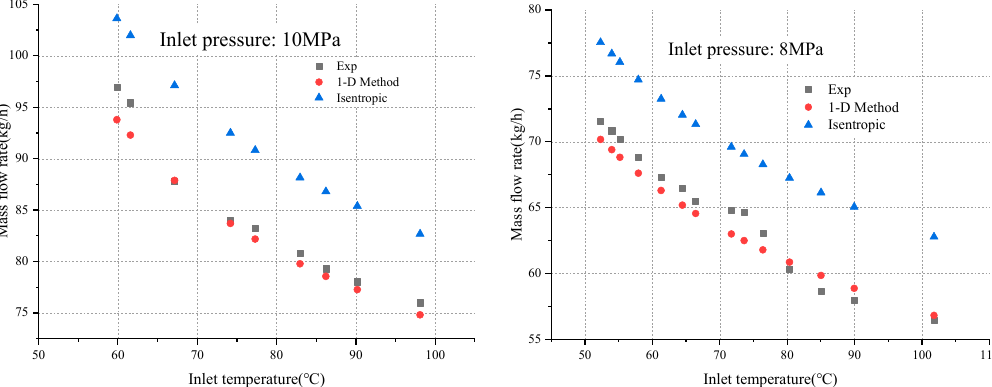
Figure 15. The comparison of the 1-D method, isentropic model and Fan’s experimental results with different inlet temperature and pressure (10 MPa-left and 8 MPa-right).